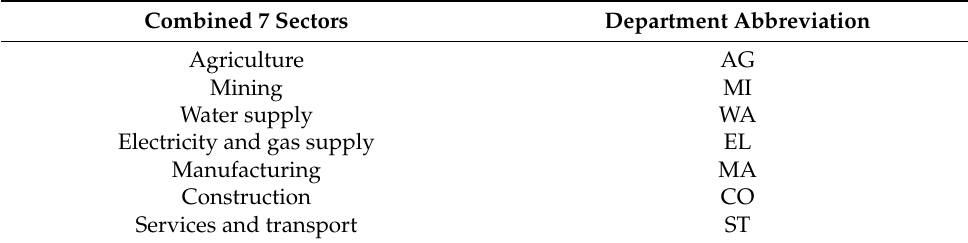
Table 3. Input–output table: Detailed list of 42 combined